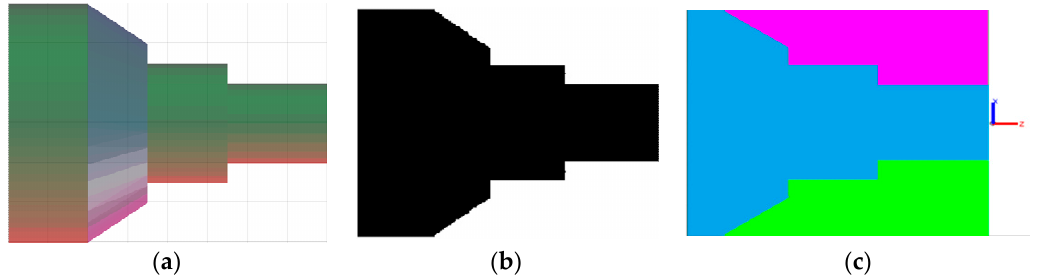
Figure 13. Image processing technique based turning operation simulation. ( a ) 3D model (front view), ( b ) 2D binary image, ( c ) path generated model). ( b ) 2D binary image, ( c ) path generated